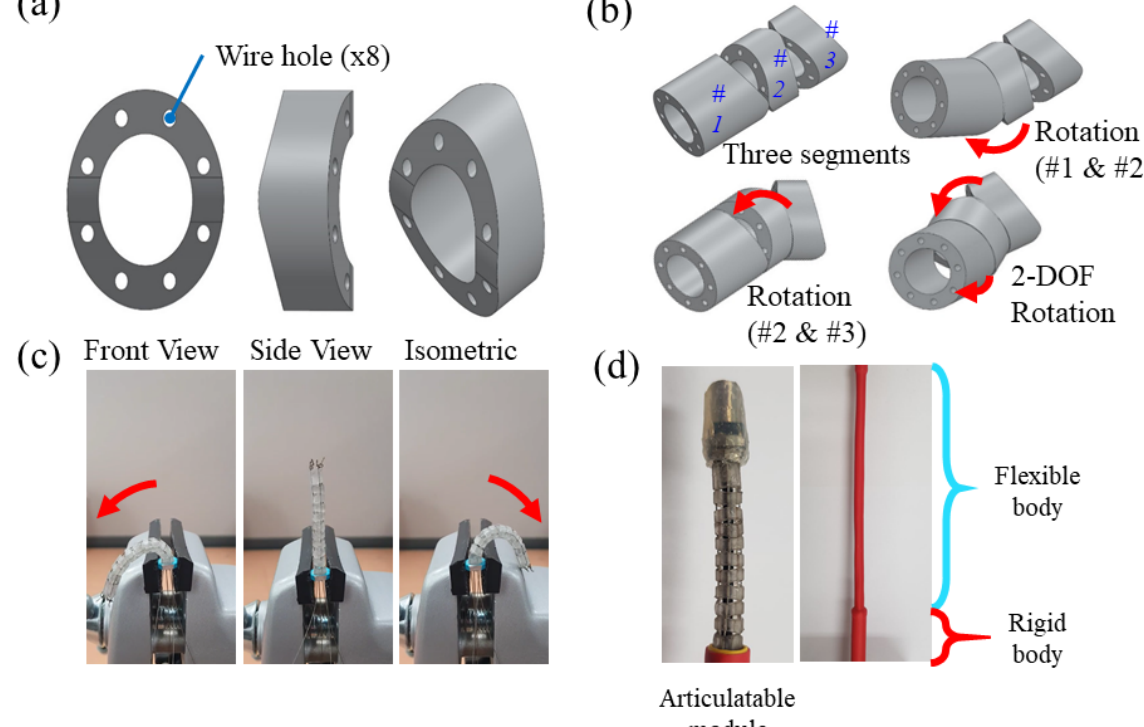
Figure 4. Structure of the continuum body: (a) 3D model of an individual unit of the continuum mechanism, (b) movement combination of three individual segments, resulting in 2-degree of freedom rotation, (c) bending motion of the 3D-printed continuum body prototype, and (d) prototype of the flexible and rigid